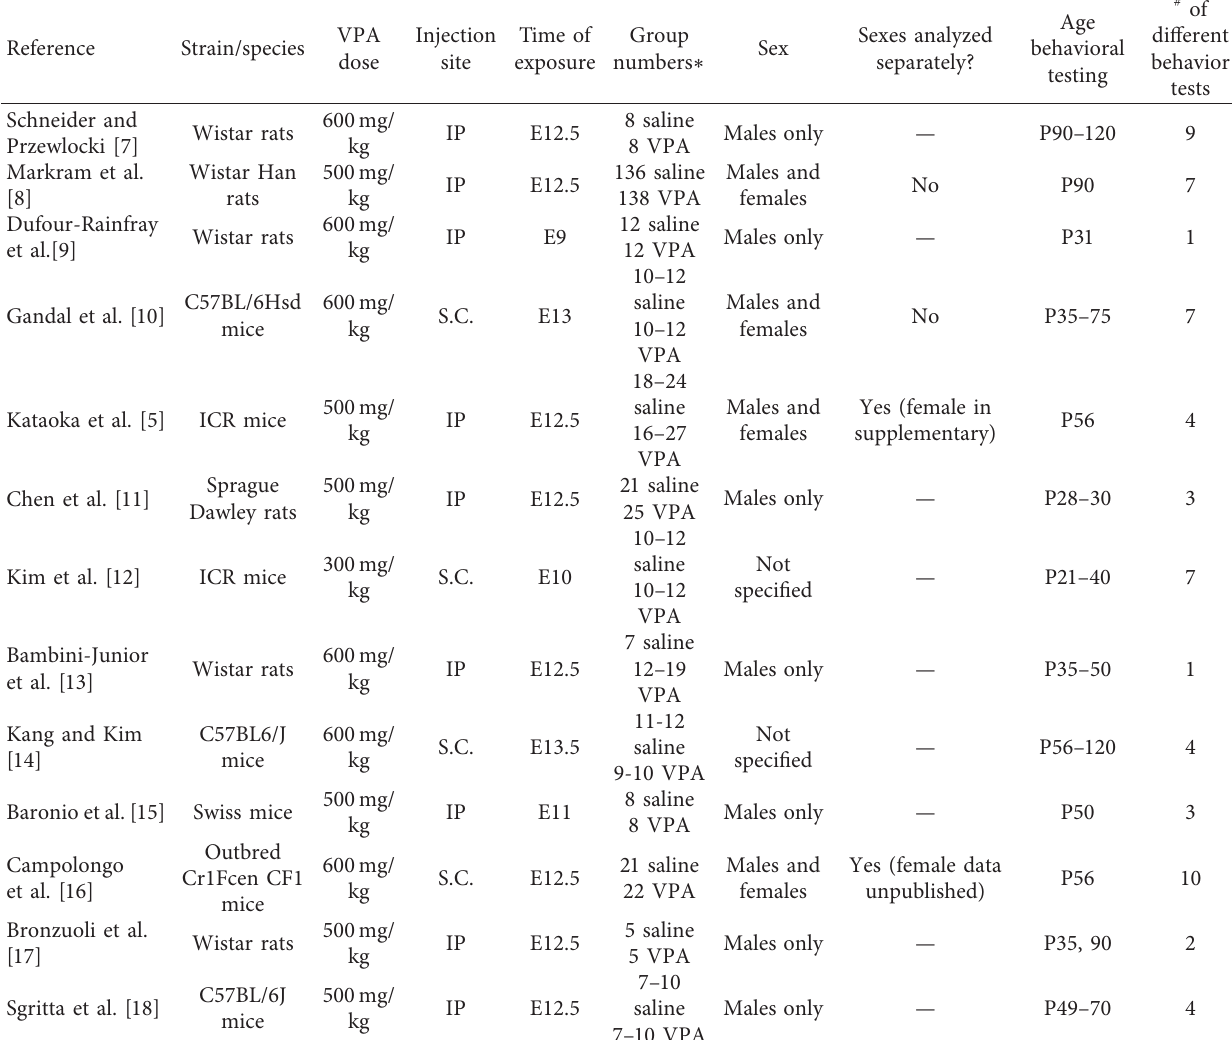
Table 1: Valproic acid model and behavioral testing